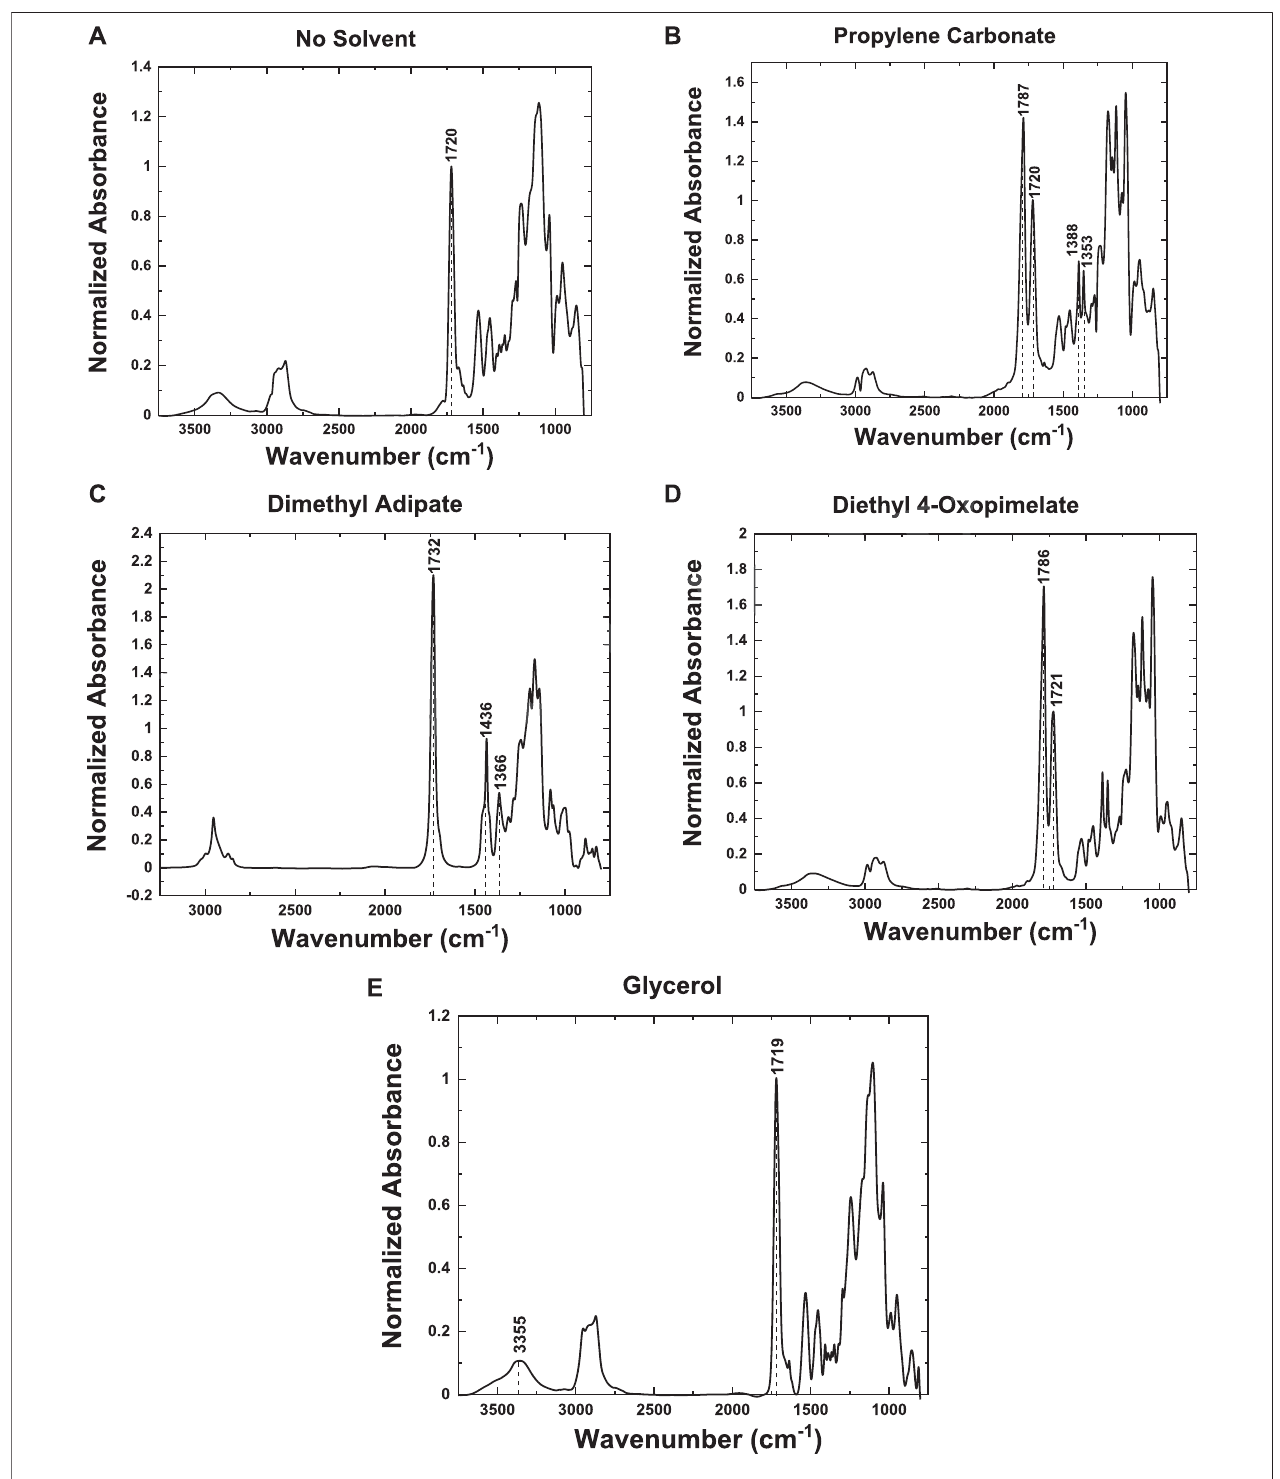
FIGURE 3 | FTIR spectra of membranes with the following plasterers: (A) no solvent plasticizer, (B) propylene carbonate, (C) dimethyl adipate, (D) diethyl 4- oxopimelate, and (E) glycerol.